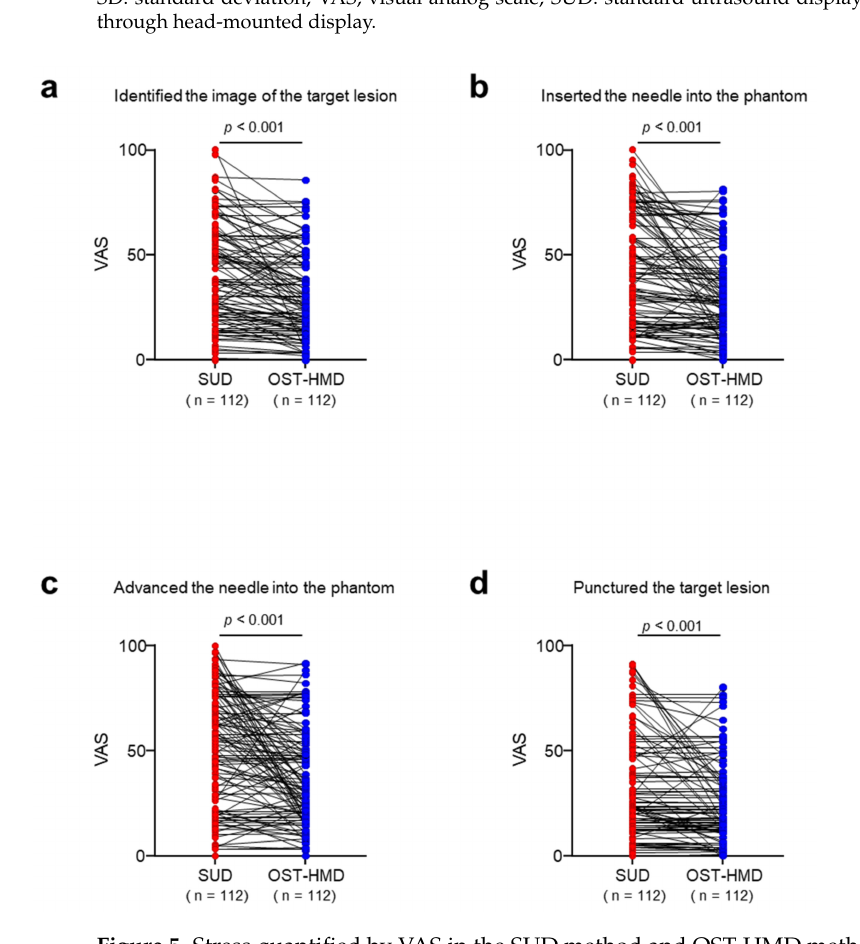
Figure 5. Stress quantified by VAS in the SUD method and OST-HMD method. n = 112 per group. p value was calculated with two-tailed paired t -test. VAS: visual analog scale, SUD: standard US display, OST-HMD: optical see-through head-mounted